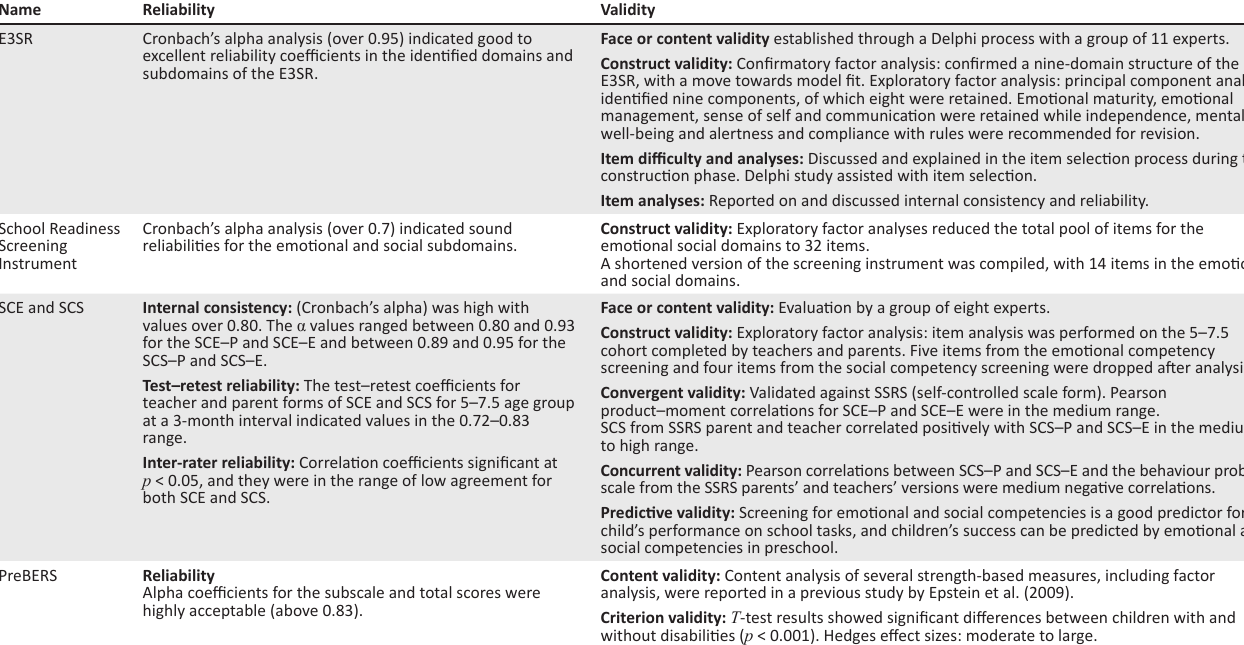
TABLE 2: Validity and reliability indices per